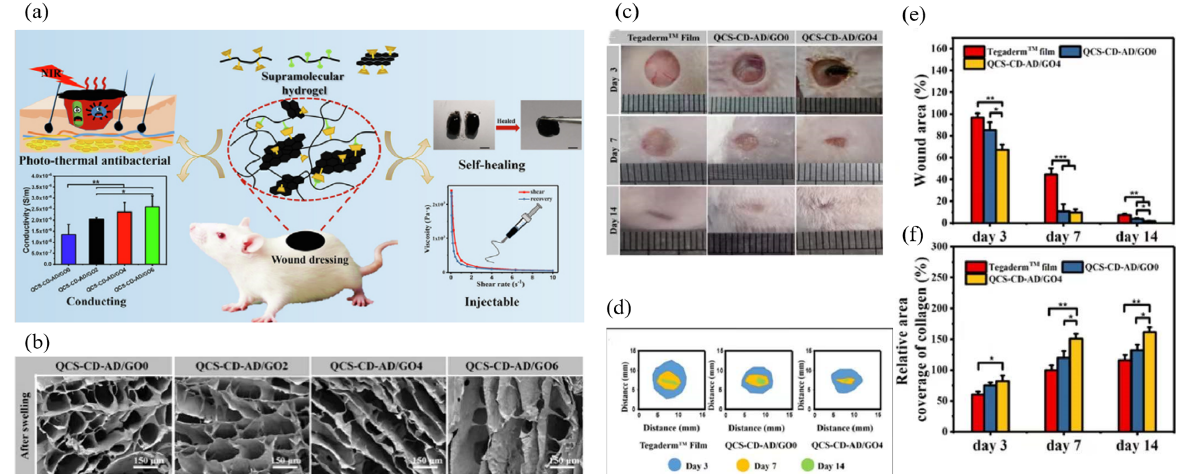
Figure 9. ( a ) Schematic diagram of hydrogel properties. ( b ) SEM of hydrogels after swelling. Scale bar: 150 µ m. ( c ) Photographs of wounds on the 3rd, 7th, and 14th days for Tegaderm TM film dressing, QCS-CD-AD/GO0 and QCS-CD-AD/GO4 hydrogels. ( d ) Schematic diagram of wound area during 14 days for the three groups. ( e ) Statistics of the wound area in each group ( n = 5). ( f ) The statistical results of relative area coverage of collagen in the regenerated tissue, data for the group of Tegaderm TM film on the 7th day were set as 100% ( n = 5). * p < 0.05, ** p < 0.01. The QCS-CD-AD/GO hydrogels with GO-CD contents of 0.2 wt%, 0.4 wt%, and 0.6 wt% in the hydrogel were